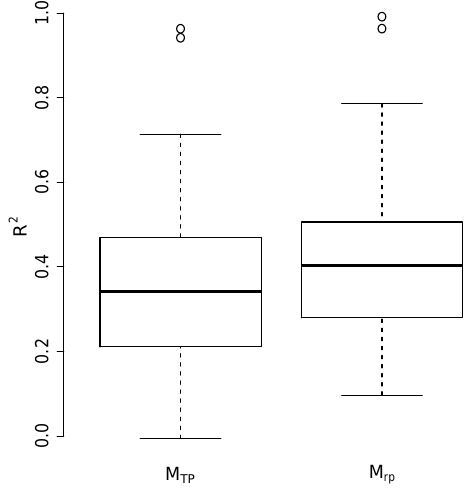
Figure 4. R 2 from all countries and crops (see Fig. 5) summarized in box plots. Medians are 0.34 for M TP and 0.4 for M rp .